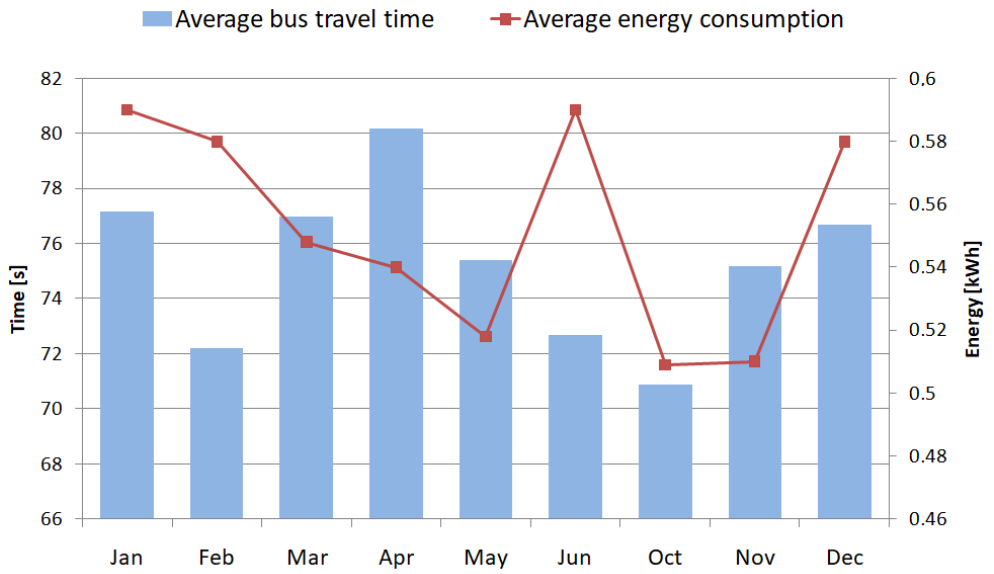
Figure 2. Average bus travel time and average energy consumption.